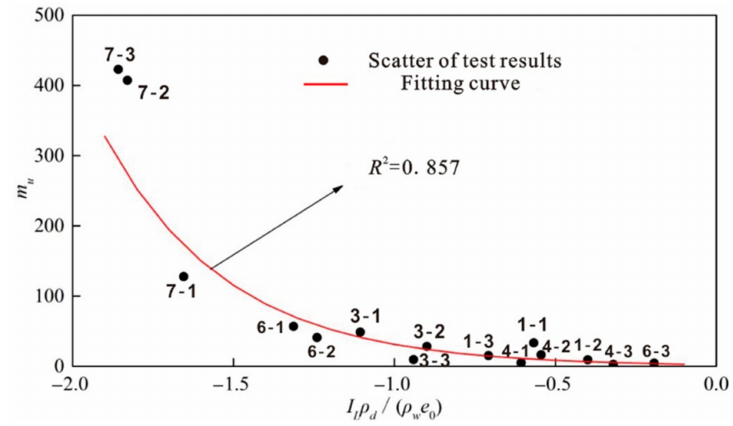
Figure 6. The fitting curve between loess structure index and physical indicators.